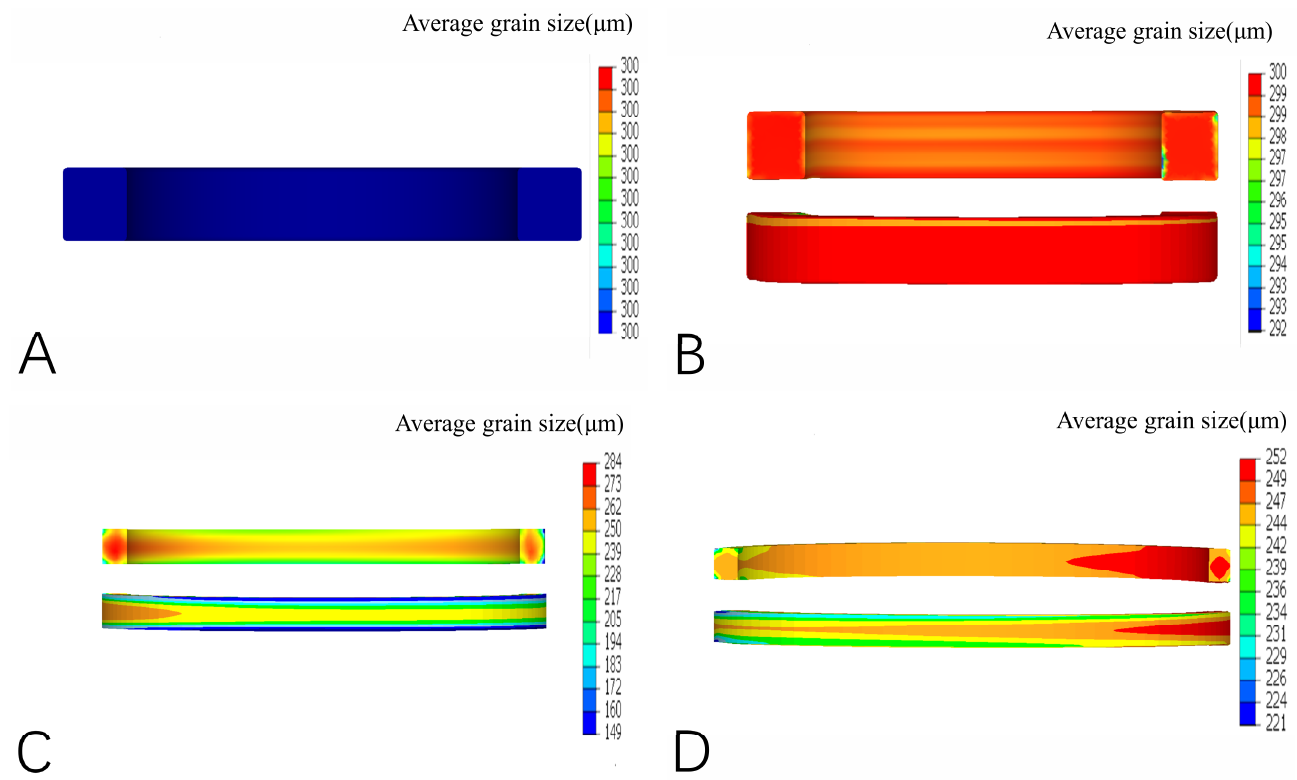
Figure 11. Grain size distribution of 2219 aluminum alloy during ring tying: ( A ) Drive roll bite stage, ( B ) Vertebral roll bite stage, ( C ) Stable rolling stage, and ( D ) Rolling completion stage.